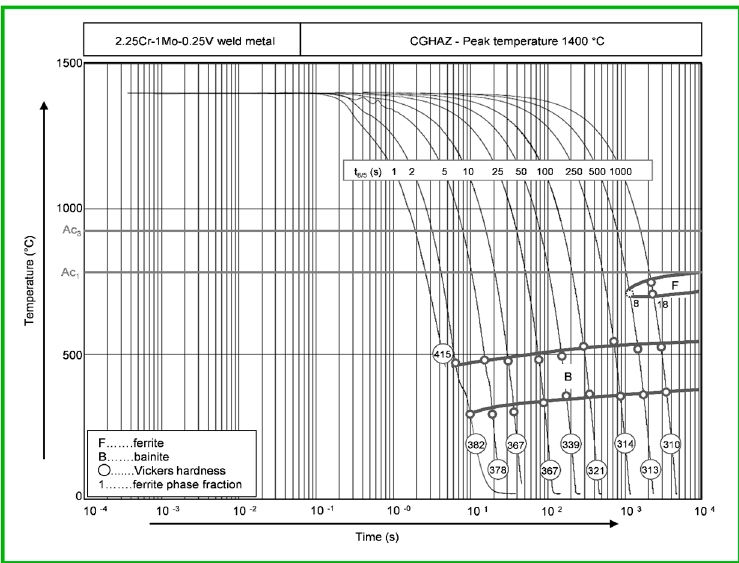
Figure 3. CCT diagram for the CGHAZ between the weld beads of a 2.25Cr-1Mo-0.25V multi-layer SAW all-weld metal with a peak temperature of 1400 °C.